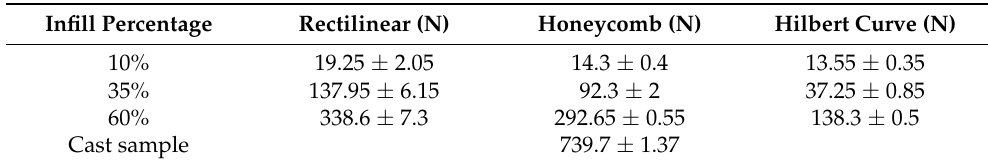
Figure 10. Flexural force graph with various infill patterns: ( a ) IP_10%, ( b ) IP_35%, ( c ) IP_60%, ( d ) Cast. Table 5. Flexural forces needed to break 3D-printed candy specimens with different patterns and various infill percentages, and cast samples.